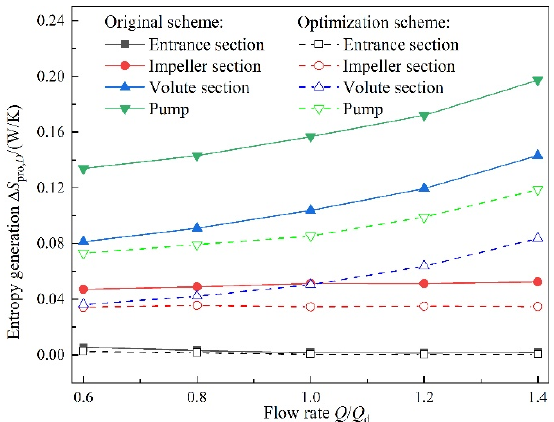
Figure 13. Components of entropy production and total entropy production in each flow passage.